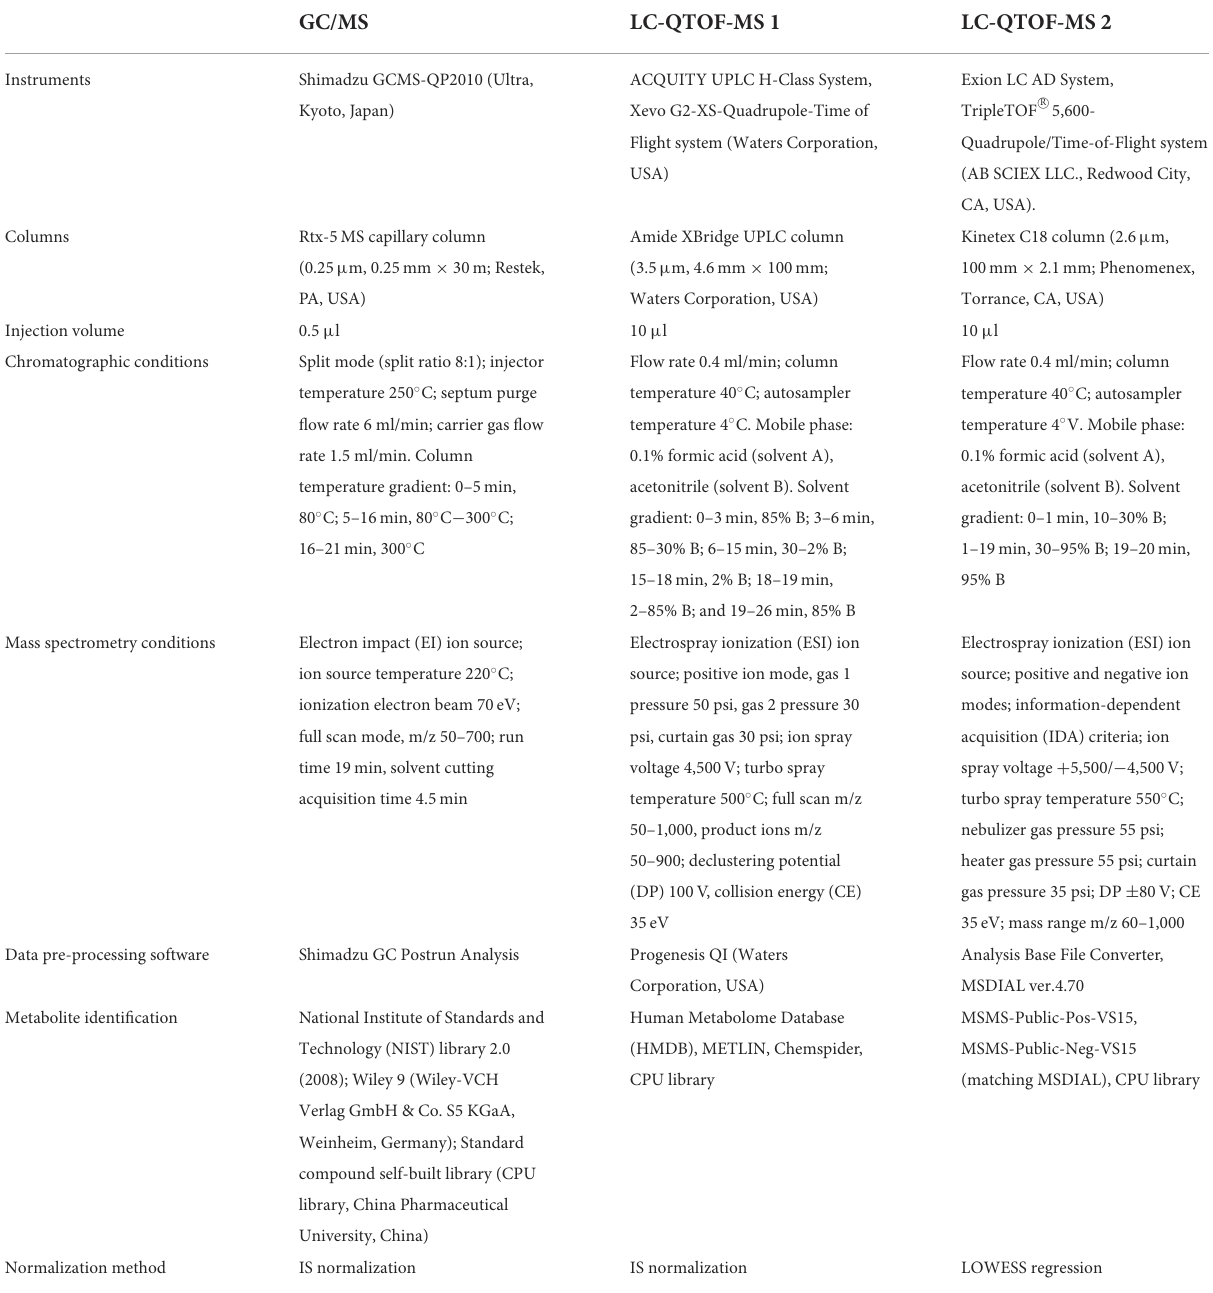
TABLE 1 Specific parameters for metabolomic